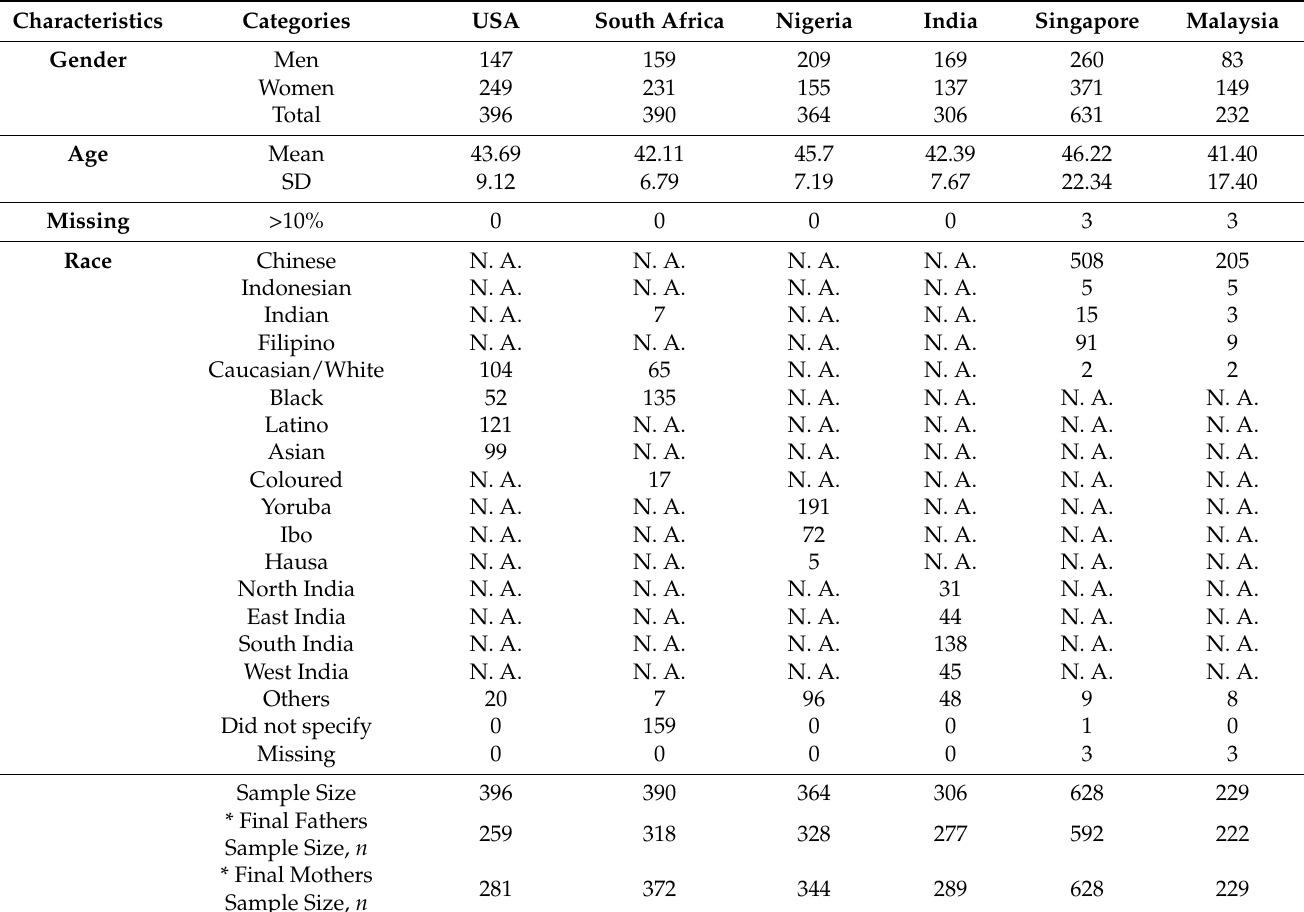
Table 1. Demographic characteristics of the